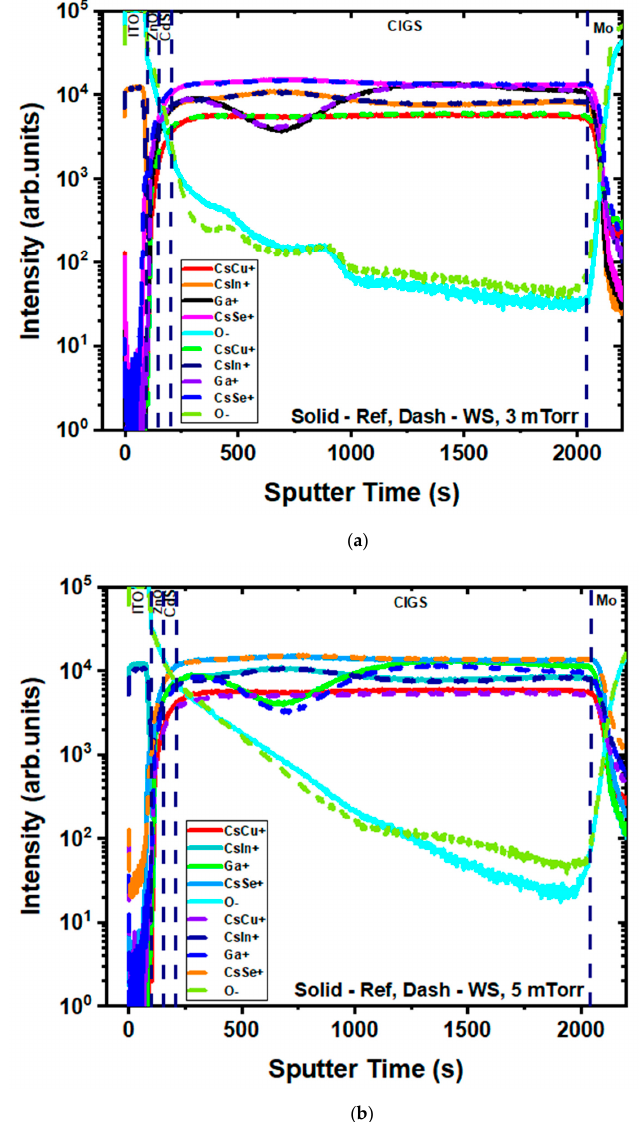
Figure 8. Secondary ion mass spectroscopy (SIMS) depth profiles for the main element for both the ( a ) 3 mTorr and ( b ) 5 mTorr experimental sets (reference: solid lines; 24 h water-soaked: dashed lines).